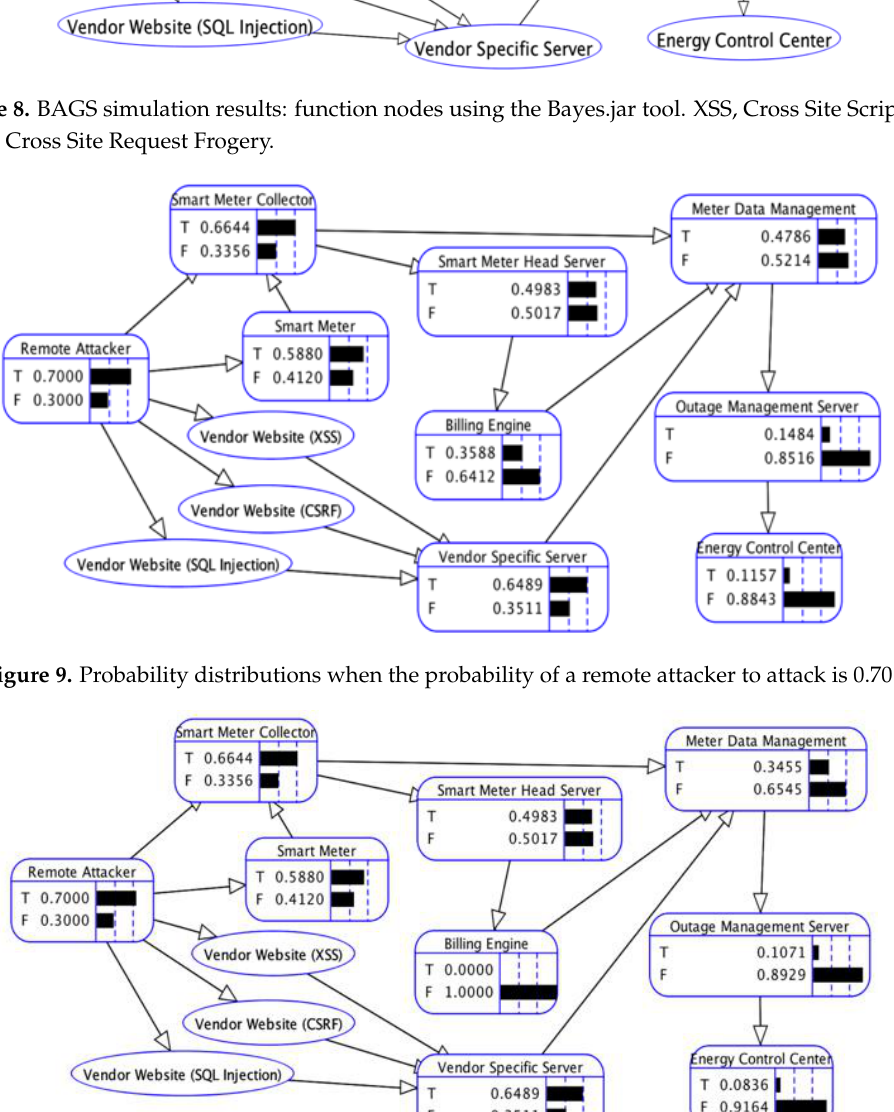
Figure 9. Probability distributions when the probability of a remote attacker to attack is 0.70. Figure 10. Unconditional probability distributions when the billing engine’s SQL injection vulnerability is patched.